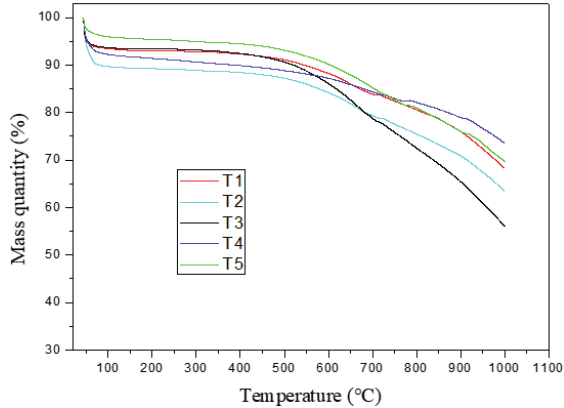
Figure 3 - Thermogravimetric curve of non-treated AC (T1) and respective treatments (T2, T3, T4 and T5), under N